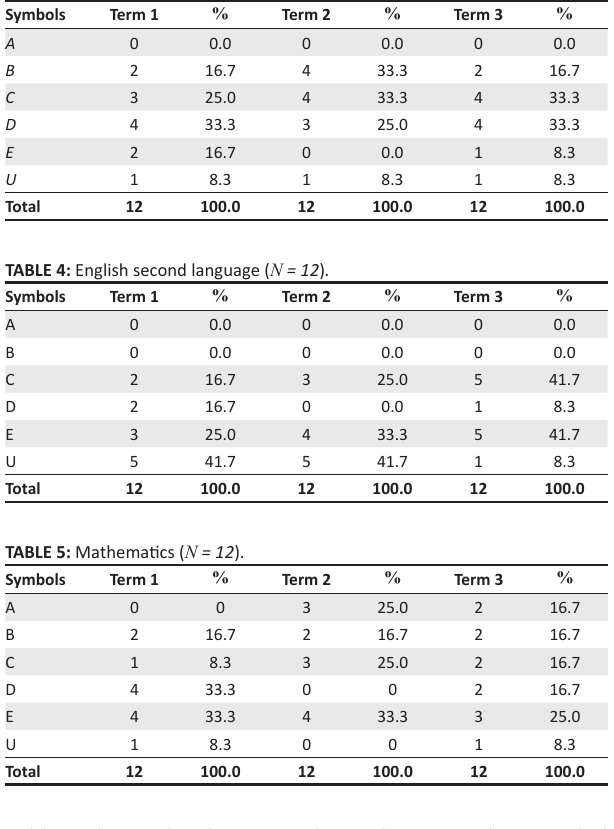
TABLE 3: Oshindonga first language ( N = 12). Symbols